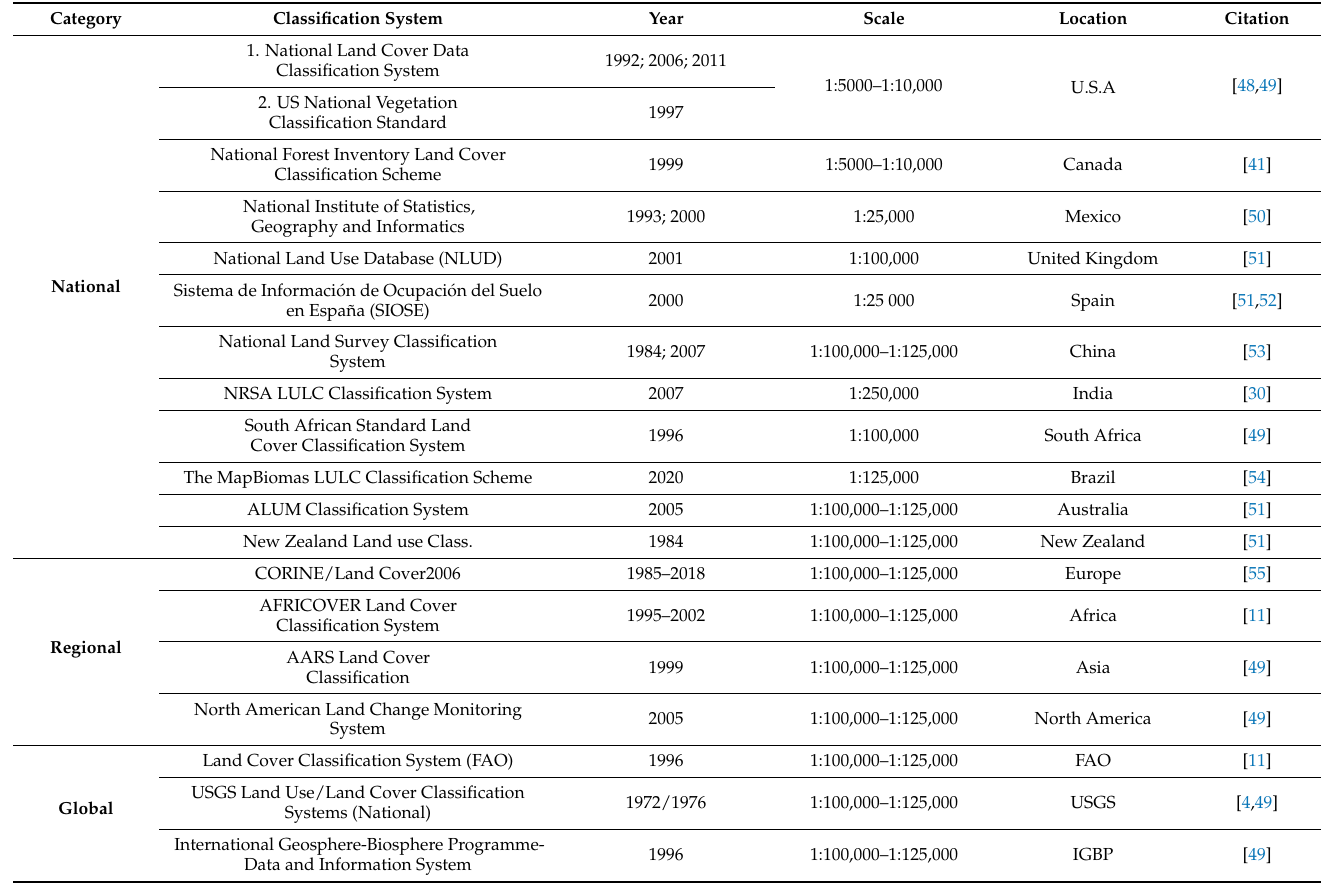
Table 3. Classification Systems used at National, Regional and Global